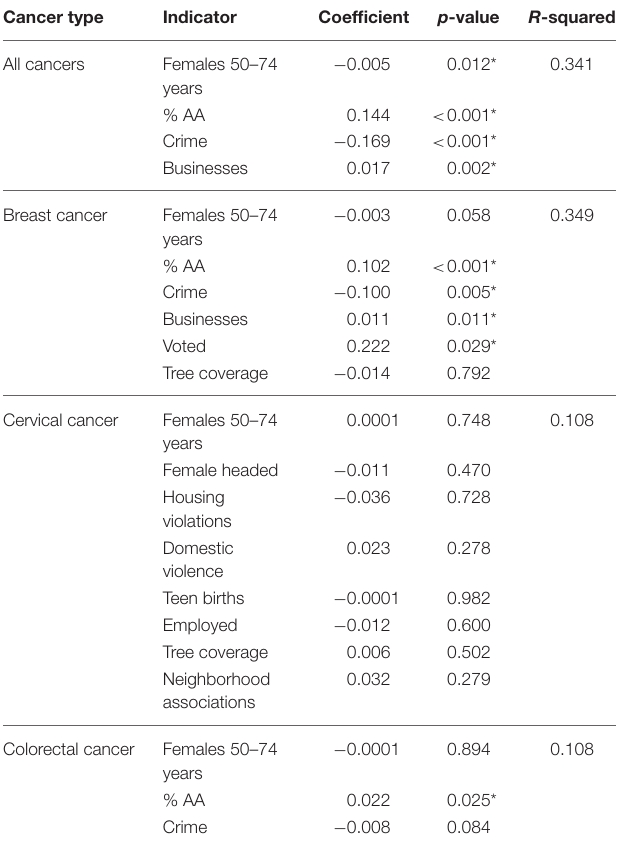
Table 3B | Adjusted ordinary least squares regression models for female cancer incidence by cancer site and neighborhood-level covariates, Baltimore City,